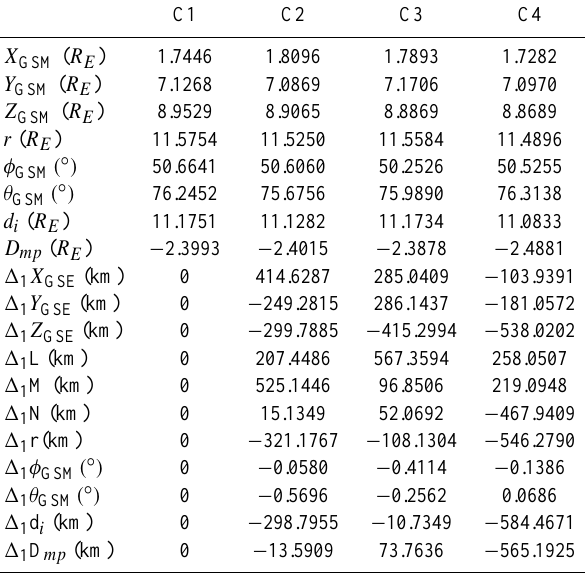
Fig. 5. An invariant-latitude ( 1 ) – MLT map of the convection equipotentials from the AMIE technique for magnetometer, Super- DARN, EISCAT/ESR and DMSP data post-integrated over the in- terval 11:40–11:45. The path of the DMSP-F15 satellite is shown, with the two thick segments showing where the satellite observed sunward convection and inverted-V electron precipitation and mag- netosheath electron precipitation. The location of the open-closed boundary (OCB, crossed by DMSP-F15 at 11:45) is also marked as are the locations of the two ESR beams and the mapped footprint of the Cluster spacecraft.